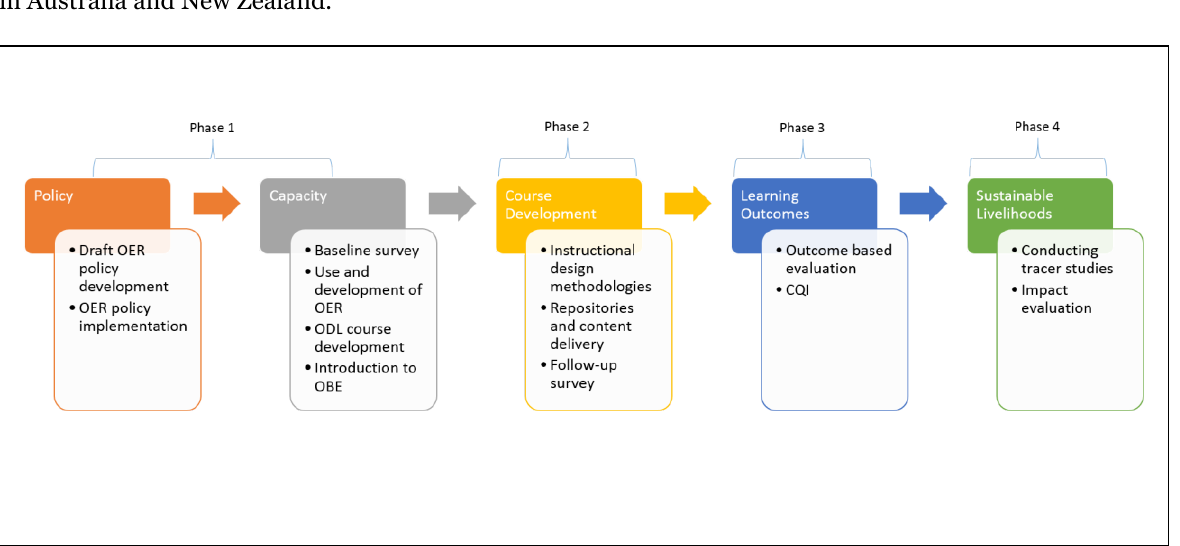
Figure 2. Project flowchart for the strategic OER implementation project in